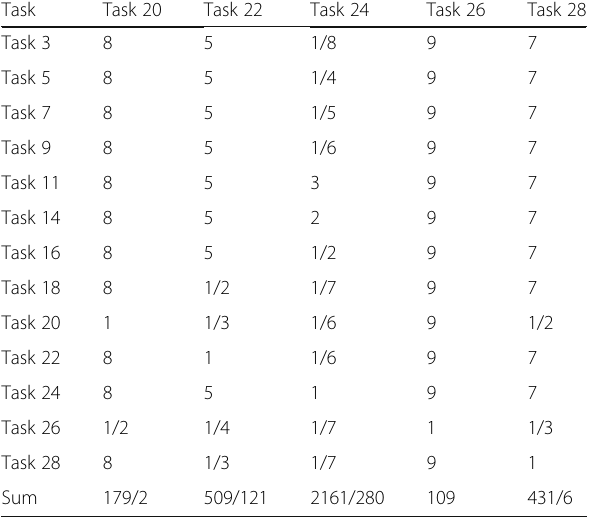
Table 4 Summation of each column-II